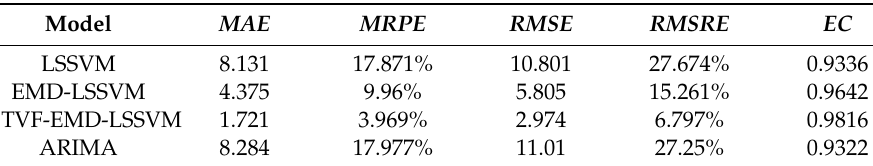
Table 2. The comparison results of different methods (A).